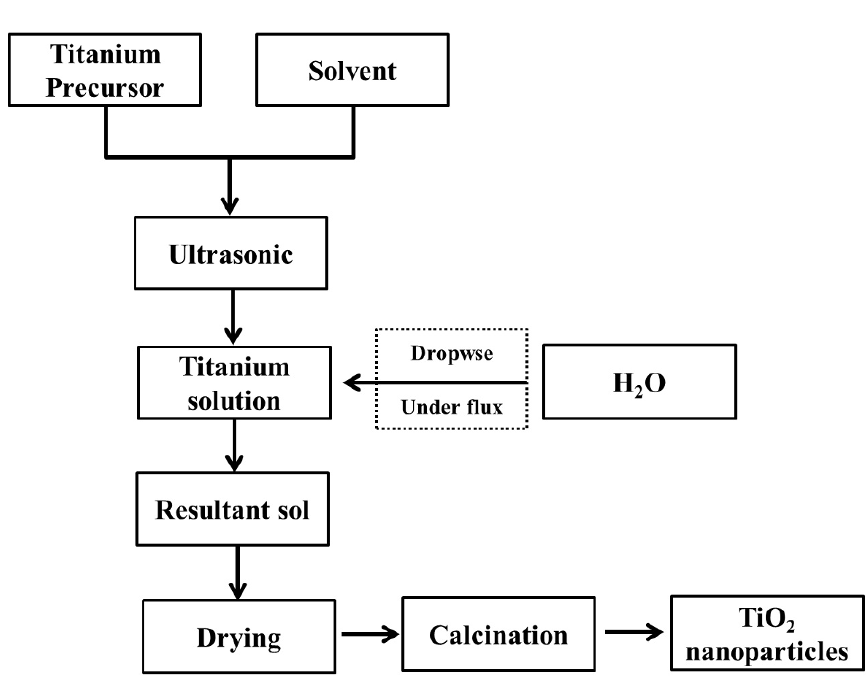
Figure 1. Scheme of the preparation of TiO